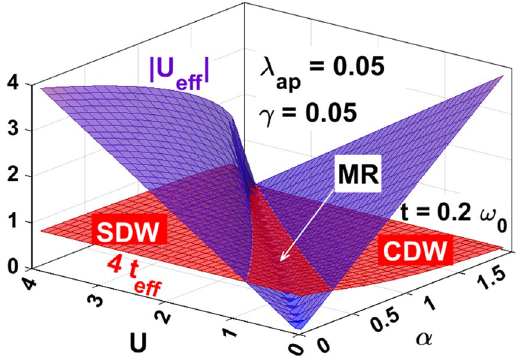
Figure 5. A 3D picture showing the behavior of | U eff | (blue) and 4 t eff (red) with U and α .